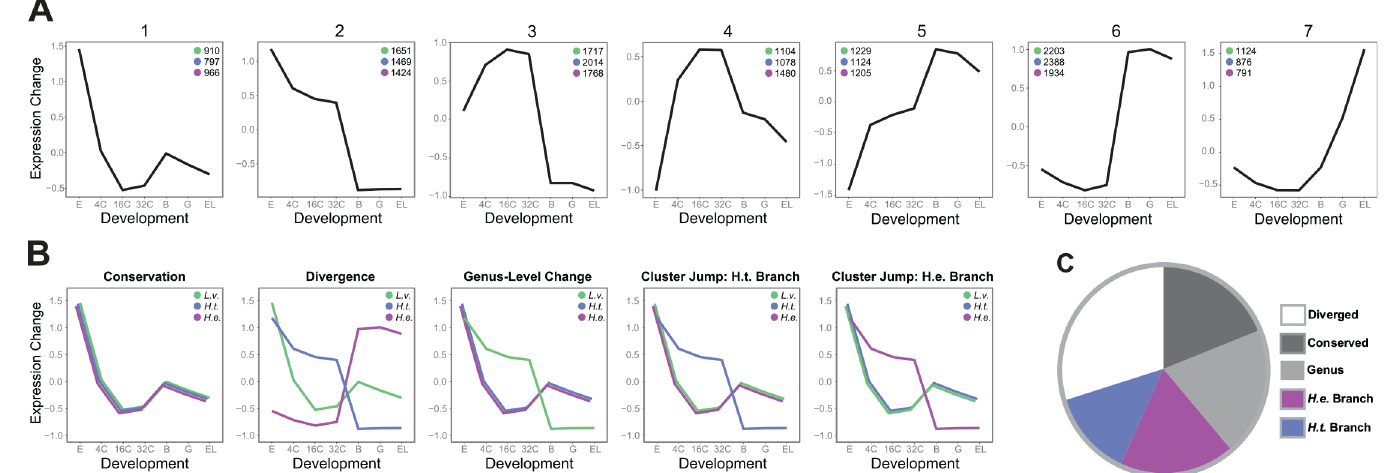
Fig 2. Comparative clustering strategy reveals cases of expression profile conservation and change within a phylogenetic framework. (A) Cluster centroids identified in the outgroup L . variegatus are shown (S2 Data), along with the number of genes in each species that were assigned to a given cluster. Green = L . variegatus , blue = H . tuberculata , and purple = H . erythrogramma . The x -axis represents developmental time, and the y -axis represents expression change. (B) Comparative clustering strategy identifies genes that exhibit the same expression profile among all three species (conservation), differ among all three species (divergence), differ between L . variegatus and the Heliocidaris species (genus-level change), or change specifically along a particular branch of the phylogeny (cluster jump in H . tuberculata or H . erythrogramma ). (C) Using a comparative clustering strategy (see 2B and Methods), we characterized expression profile divergence (white, 29.8%), conservation (dark grey, 19.1%), and genus-level change (light grey, 19.8%) across the transcriptome. We also detected branch-specific change in H . tuberculata (blue, 13.5%) and H . erythrogramma (purple, 17.8%) (S1 Table).